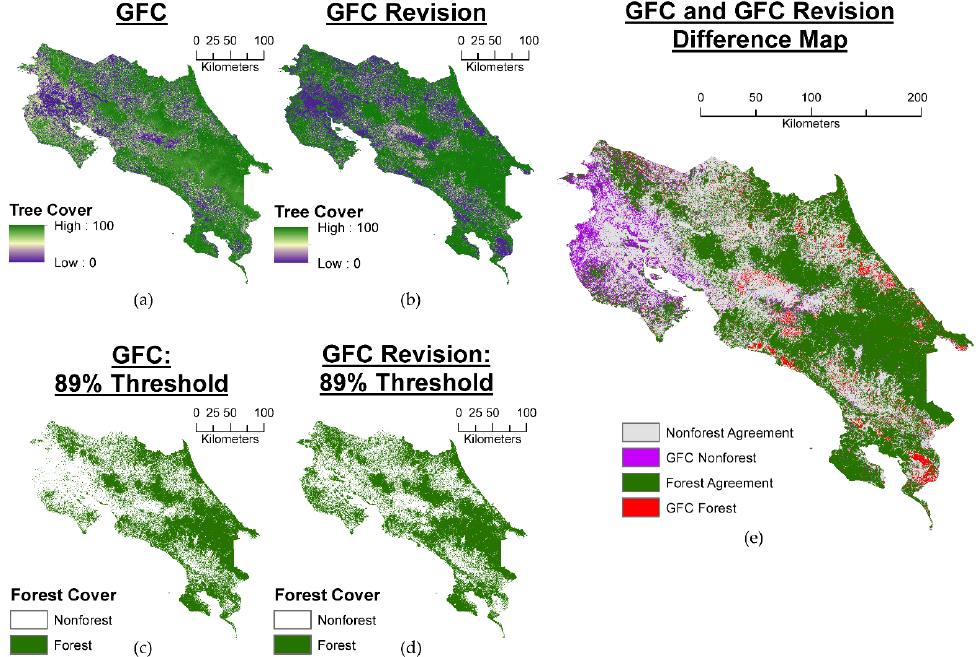
Figure 8. Changes in tree and forest cover from the correction of the GFC tree cover product over Costa Rica. Panels ( a , b ) show the original and revised tree cover estimates, respectively. Panels ( c , d ) show forest/nonforest maps derived from the original and revised GFC maps, respectively, using a forest threshold of ≥ 89% tree cover. Panel ( e ) shows the difference between Panels ( c , d ), highlighting forest added via correction (purple) and removed via correction (red). Table 5. Confusion matrices for the original and revised GFC forest/nonforest maps, showing area-corrected estimates of overall accuracy (mean ± confidence interval), the per-class errors of omission (Producer’s accuracy), and the per-class errors of commission (User’s accuracy). Confusion matrices were derived from independent testing data (n = 732), but these are displayed as a proportion of map area [59]. The colors correspond to the error types mapped in Figures 9 and 10. See Table A4 for the area-corrected accuracy estimates for each separate step of the correction process (precipitation and elevation, and agricultural masking).